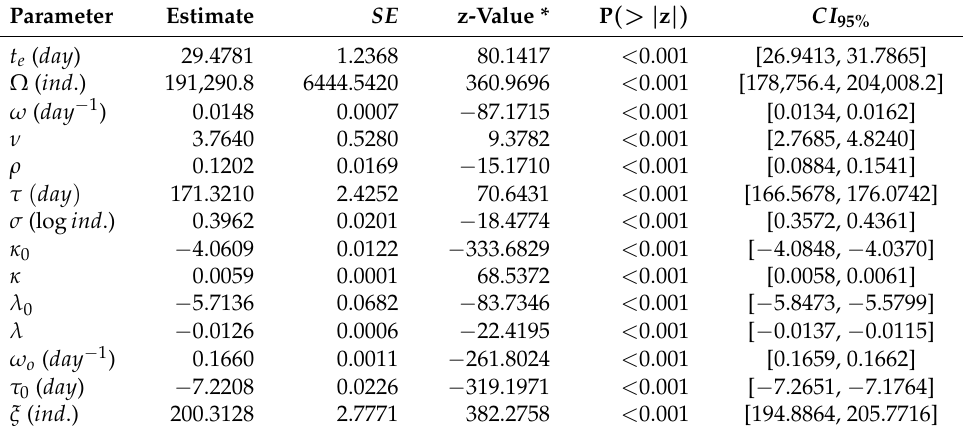
Table notes: ind ., individuals ; t e (day) is the duration of the exponential growth phase after the outbreak; Ω and ξ ( ind .) determine the ultimate epidemic size (detected) as ξ + Ω ; ω > 0 (day − 1 ) is the “intrinsic” growth rate constant for the sub-exponential growth phase; ν > 0 is a growth acceleration parameter, ρ is a shape parameter controlling the skewness of the growth curve during the sub-exponential growth phase; τ (day) is a constant of integration determined by the initial conditions of the epidemic outbreak; σ is the logarithmic-scale standard deviation of the log-normal distribution fitted to the daily new positive case reporting data; κ 0 and κ are the logit-scale intercept and slope for the daily probability α t that an active case recovers at time